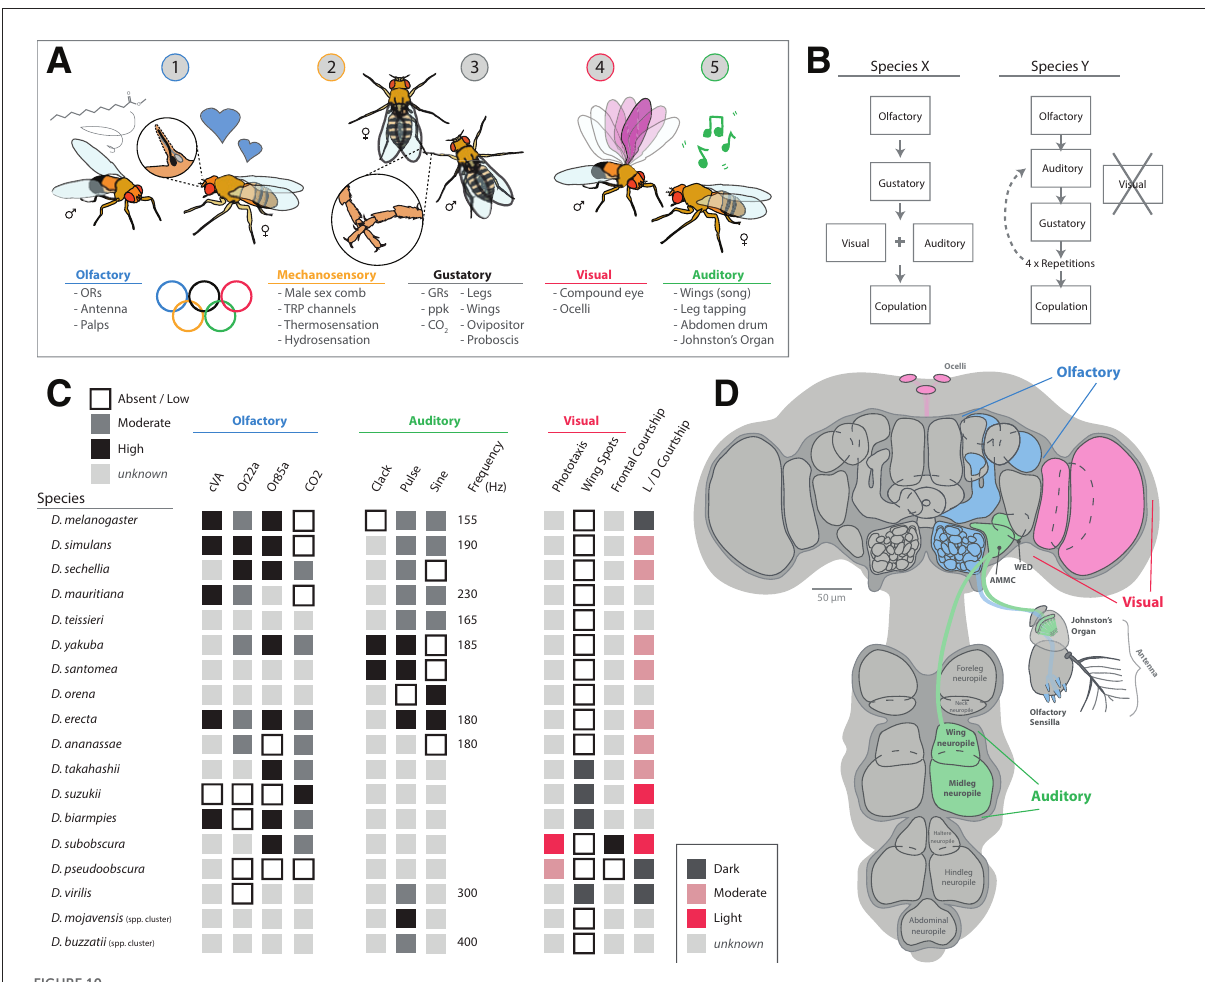
FIGURE10 Multimodal sensory integration. (A) Courtship is a great behavior to address multimodal activation, as many sensory systems are active in different stages across male and female dances as well as mate selection. (B) Each species uses five primary senses (smell, taste, sight, sound, and touch) in different temporal and spatial patterns, as well as species-specific differences in a dominant mode (e.g., visual vs. olfactory courtship priorities). (C) An example table of species examinations across sensory cues during courtship dances. (D) An overview diagram of sensory integration and neural pathway overlay for sight, sound, and